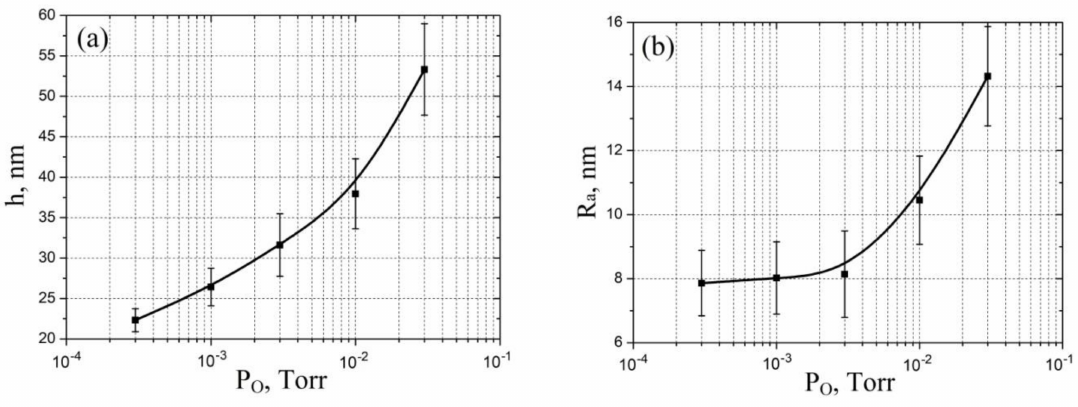
Figure 4. Experimental study of vanadium oxide film geometrical parameters dependence on oxygen pressure: ( a )—thickness; ( b )—surface roughness.